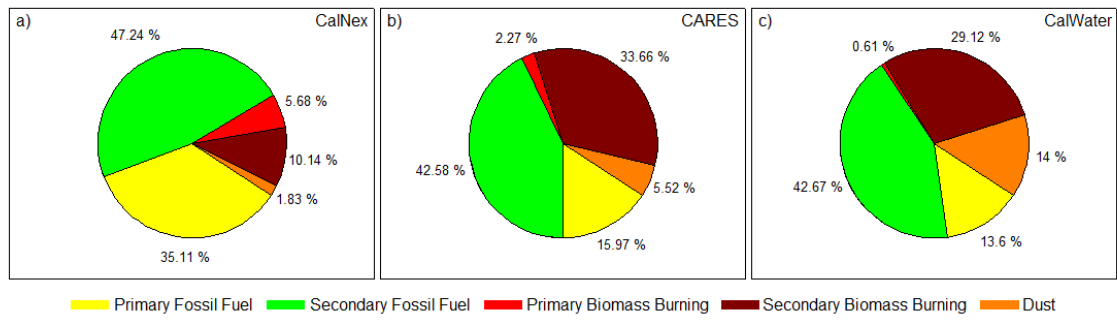
Fig. 5. Overall aerosol sources detected with the A-ATOFMS in the three aircraft campaigns: (a) CalNex, (b) CARES, and (c) CalWater. 3 measurements and the aircraft measurements are mainly on the Sacramento area. Both seasons in northern